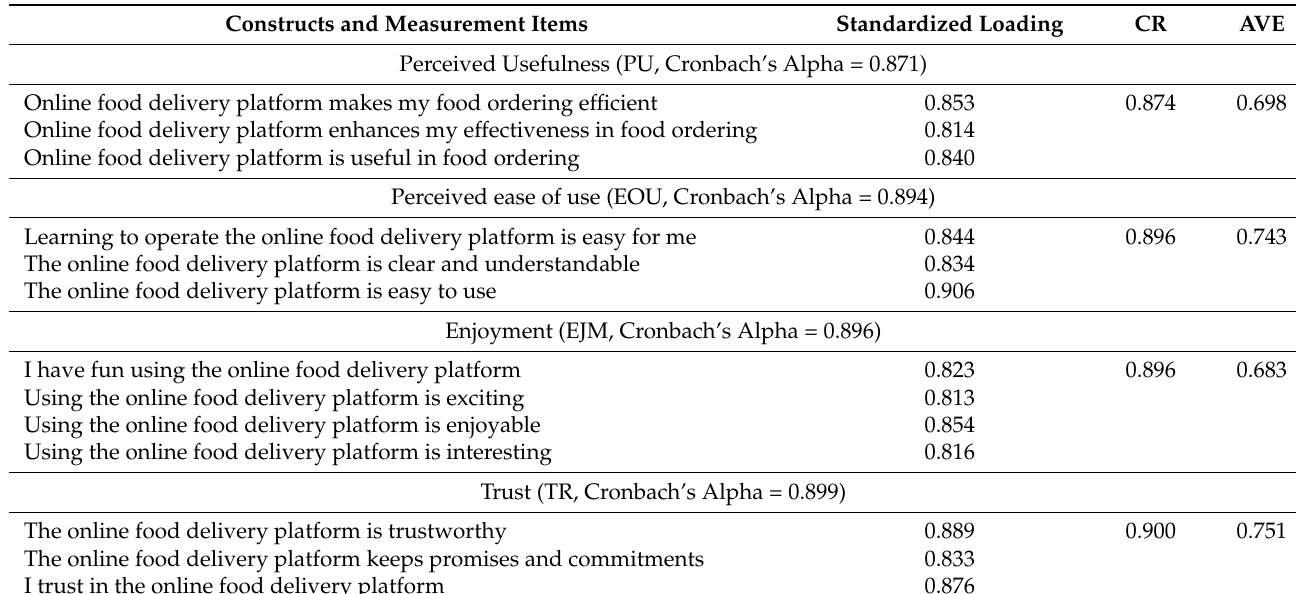
Table 2. Results of confirmatory factory